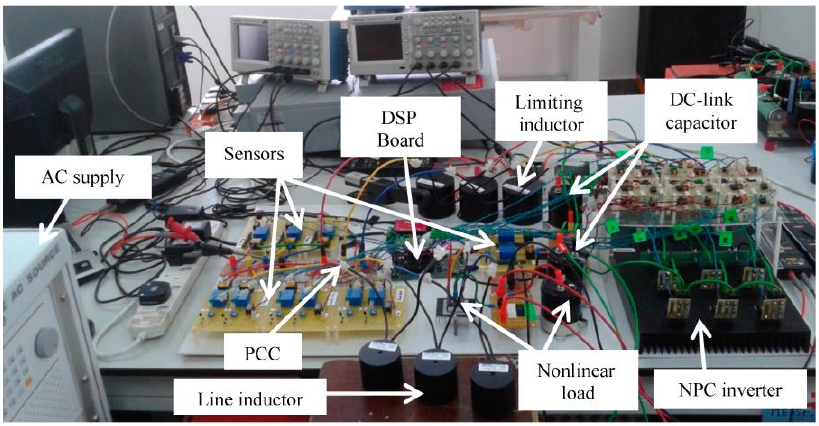
Figure 12. Experimental setup for the proposed SAPF.